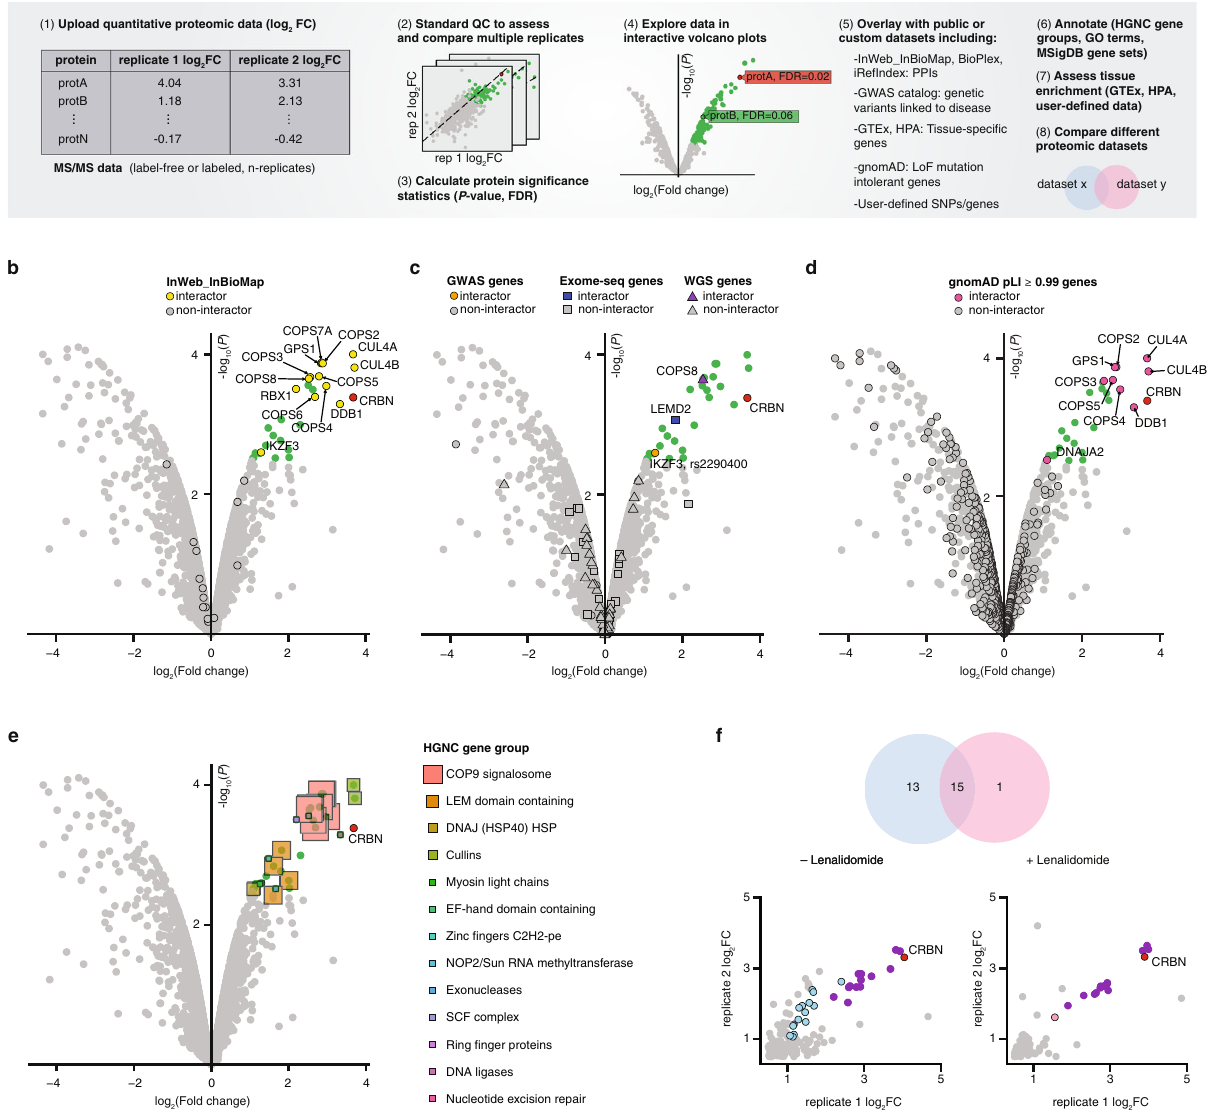
Fig. 1 Overview of Genoppi. a Overview of the Genoppi features. b Volcano plot of published CRBN interaction data in MM1S multiple myeloma cells versus control samples. The x -axis shows the log 2 FC of each identi fi ed protein and the y -axis the corresponding − log 10 P value. The bait protein (CRBN) is marked in red; statistically signi fi cant interactors with log 2 FC > 0 and FDR ≤ 0.1 are in green; non-interactors that do not pass this threshold are in gray. Known interactors of CRBN in InWeb_InBioMap are marked by black border circles; those signi fi cant in the experimental data are highlighted in yellow (overlap enrichment P = 1.1e − 21, from one-tailed hypergeometric test). c The volcano plot from ( b ) is overlaid with genetic data. Proteins encoded by genes mapped from acute lymphoblastic leukemia GWAS SNPs (GWAS genes), signi fi cantly mutated genes identi fi ed through exome sequencing in multiple myeloma (Exome-seq genes), or recurrently mutated cis -regulatory elements identi fi ed via whole-genome sequencing in multiple myeloma (WGS genes) are marked by black border circles, squares, or triangles, respectively; those signi fi cant in the experimental data are highlighted in orange, blue, or purple, respectively. Overlap enrichment was not calculated since part of this gene list was mapped from GWAS SNPs using linkage disequilibrium information. d The volcano plot from ( b ) is overlaid with proteins intolerant of LoF mutations in gnomAD. Proteins encoded by genes with pLI scores ≥ 0.99 are marked by black border circles; those signi fi cant in the experimental data are highlighted in magenta (overlap enrichment P = 0.087, from one-tailed hypergeometric test). e The volcano plot from ( b ) is overlaid with HGNC gene group annotations (square markers) for the signi fi cant interactors. Marker size scales with the number of interactors assigned to each group. f Illustration of Genoppi ’ s ability to make comparisons between proteomic experiments under different genetic or pharmaceutical perturbations; in this case, the comparison of CRBN interactors in untreated ( − Lenalidomide) versus lenalidomide-treated ( + Lenalidomide) MM1S cells. Top: Venn diagram representing the overlap of signi fi cant (log 2 FC > 0 and FDR ≤ 0.1) interactors between the two conditions. Bottom: scatter plots showing log 2 FC of identi fi ed proteins in two replicates ( x - and y -axis, respectively) for each condition. Interactors shared between conditions are shown in purple; interactors unique to each condition are in blue or pink, respectively. FC fold change, MS mass spectrometry, QC quality control, FDR false discovery rate, PPI protein – protein interaction, LoF loss-of-function, SNP single-nucleotide polymorphism. Source data are provided as a Source Data fi